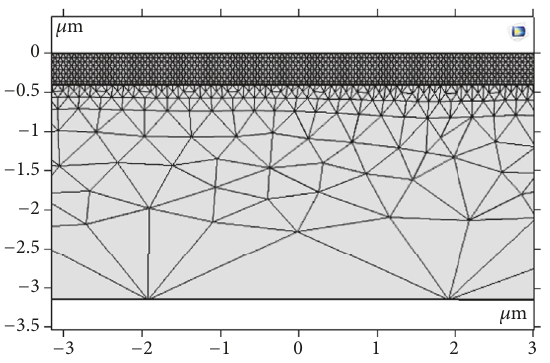
Figure 3: The refined mesh for Si 0.2 Ge 0.8 /Si.